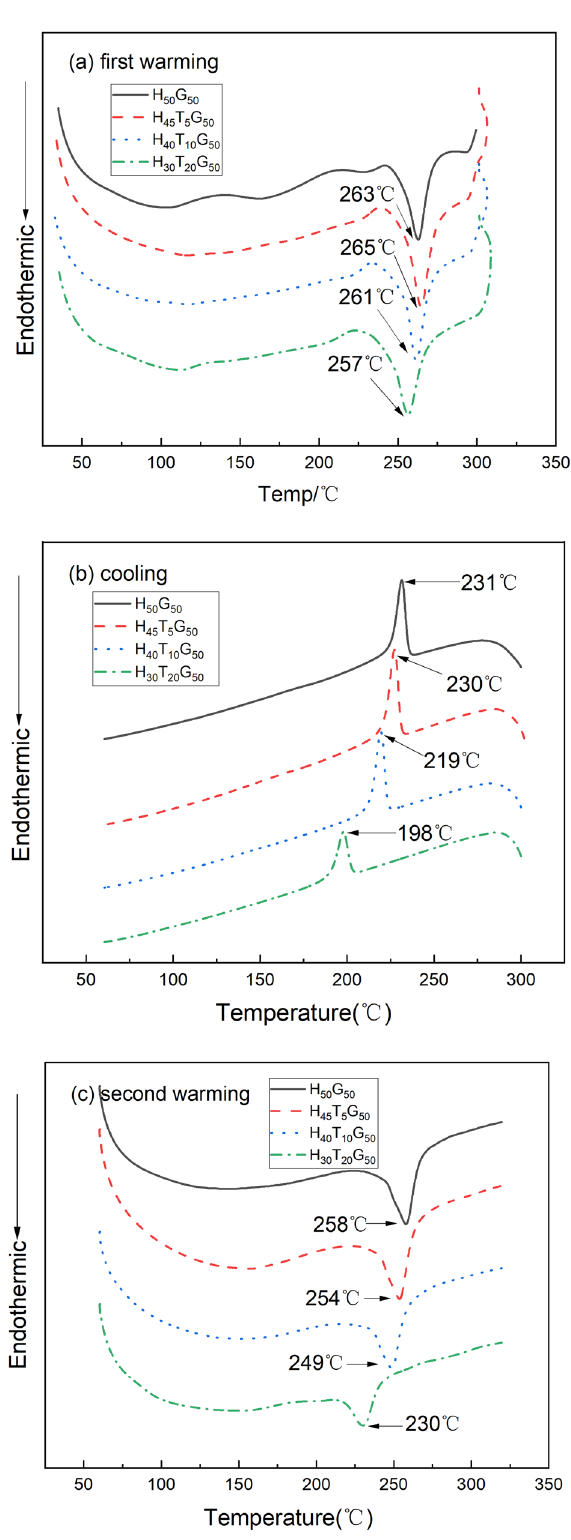
Figure 1: DSC curves of the fi rst warming ( a ) , the cooling ( b ) , and the second warming ( c ) scans of H 50 G 50 , H 45 T 5 G 50 , H 40 T 10 G 50 , and H 30 T 20 G 50 .